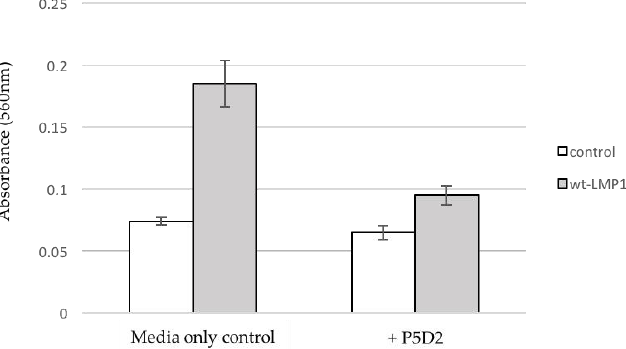
Figure 7. Ligand-induced β 1 integrin signalling facilitates LMP1-mediated ERK and FAK phosphorylation, and protects epithelial cells from anoikis. ( A ) Cells were held in single-cell suspension for one hour and then plated onto poly-L-lysine or fibronectin-coated plates for one, two, three and four hours, respectively, prior to harvesting protein lysates. Western blotting with antibodies that specifically recognise threonine 202/tyrosine 204-phosphorylated p44/42 MAPK and tyrosine 397-phosphorylated FAK revealed the requirement for β 1 integrin ligation for LMP1-mediated ERK-MAPK and FAK activity; ( B ) Control and wildtype LMP1-expressing cells were held in single-cell suspension for one hour by plating onto polyHEMA-coated plates prior to assessing cell viability by MTT assay, absorbance read at 560 nm. The histogram displays the average of technical triplicates for each sample, and is a representative of biological triplicate experiments.